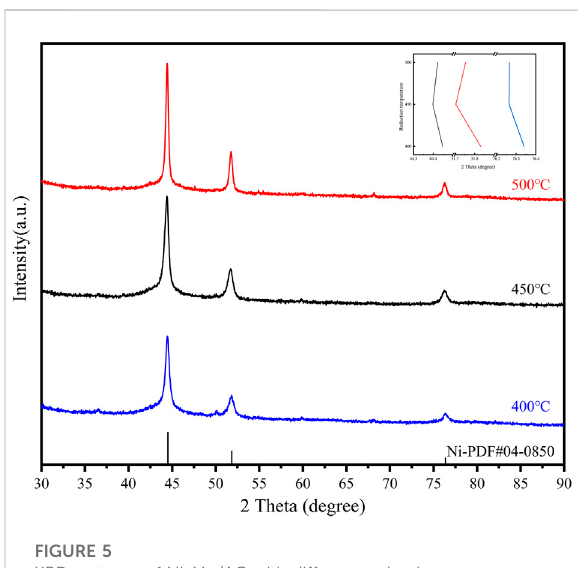
FIGURE 5 XRD patterns of Ni 4 Mo/AC with different reduction temperatures. The inset image shows the trend in the shift of the three main